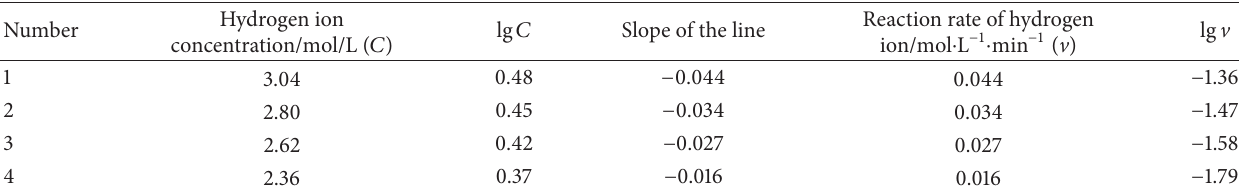
Table 4: Reaction rates at the different concentrations (at 80 ∘ C).